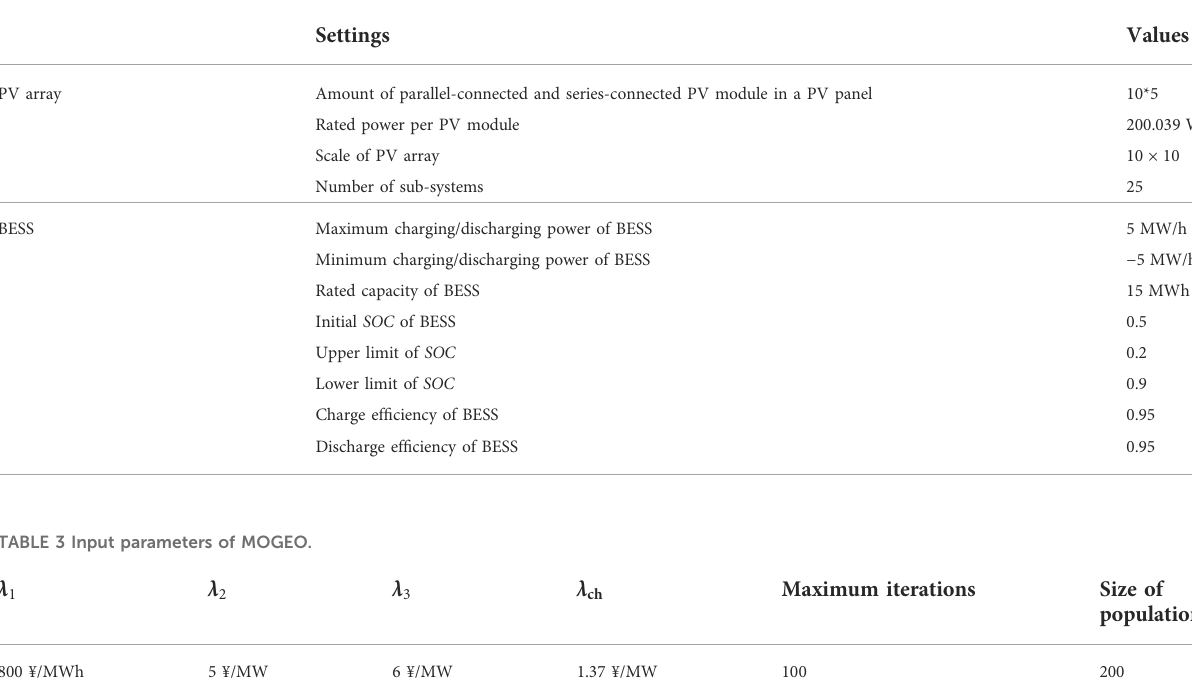
TABLE 2 Key parameters of the joint PV energy storage system.